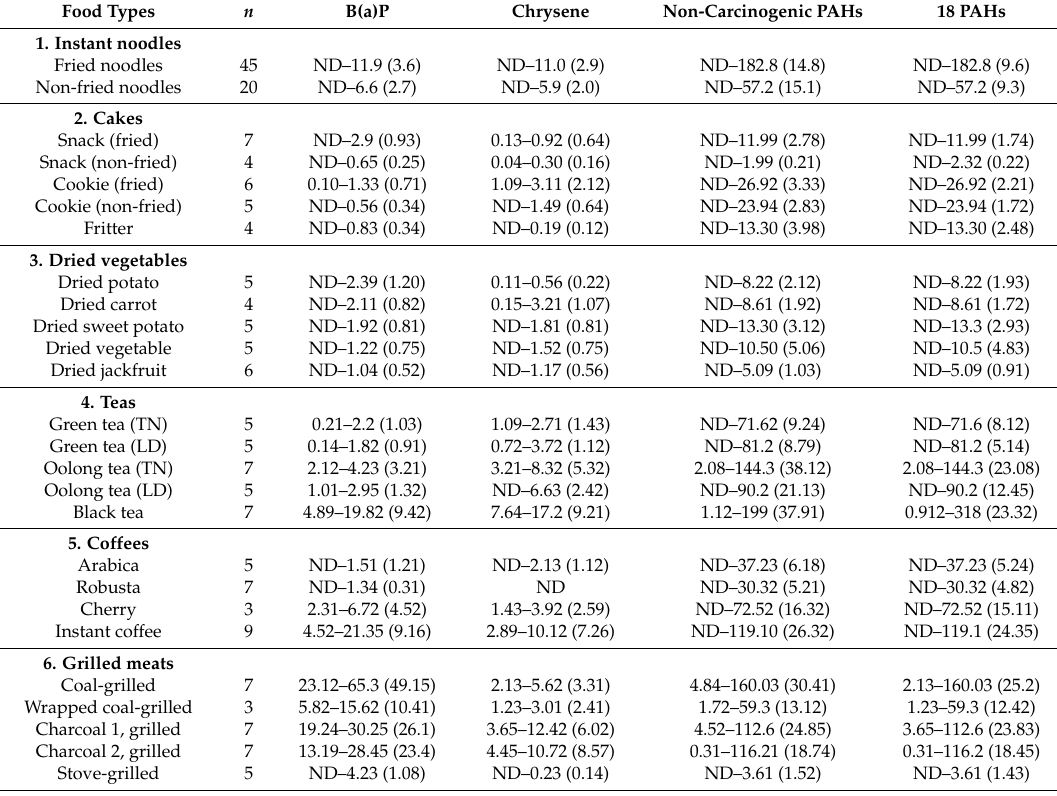
Table 2. The concentrations ( µ g/kg) of benzo(a)pyrene (B(a)P), chrysene, non-carcinogenic PAHs, and total 18 PAHs in 198